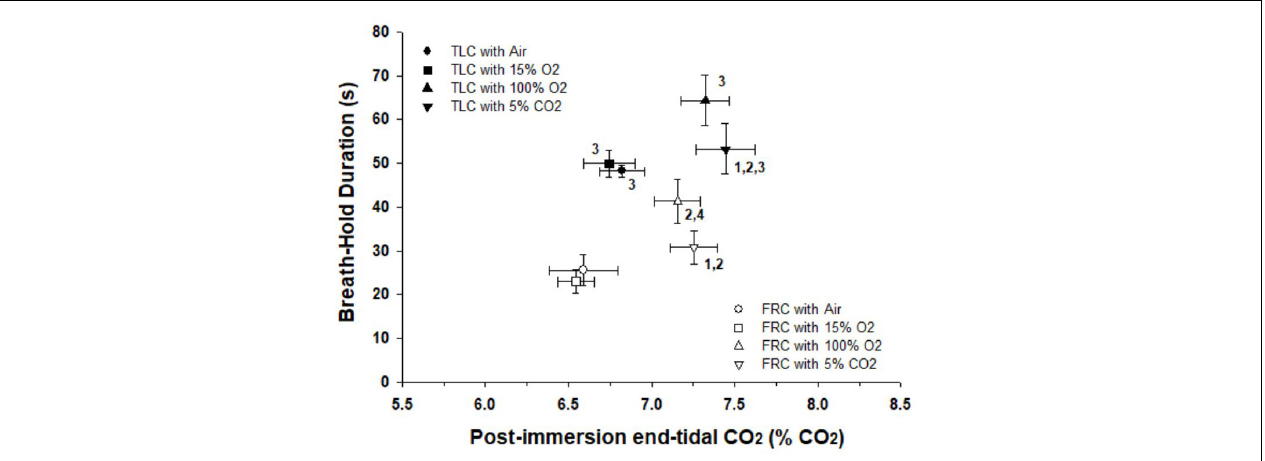
FIGURE 4 | Breath holds after face immersion into room temperature water did not end at a consistent etCO 2 , and BHD was always longer at TLC than at FRC. There were significant differences between the post-immersion etCO 2 ’s after pre-breathing different gases before breath holds. Thus there was no consistent etCO 2 that initiated the termination of the breath holds. For each gas breathed before the breath hold, BHD at TLC was always longer than BHD at FRC. 1, Post-immersion etCO 2 is significantly greater than post-immersion etCO 2 after pre-breathing air at that lung volume. 2, Post-immersion etCO 2 is significantly greater than post-immersion etCO